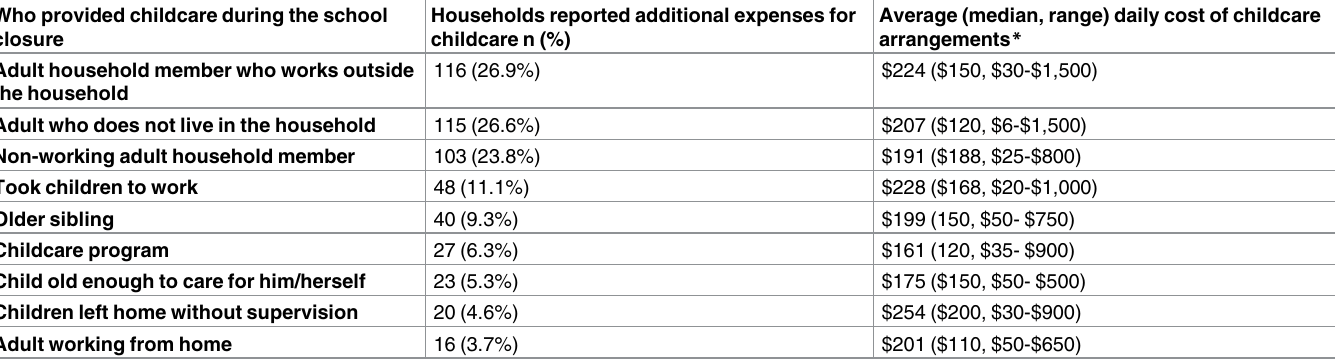
Table 7. Cost of alternative childcare options. HarrisonCounty School District, Mississippi, August 2012. Who provided childcare during the school closure